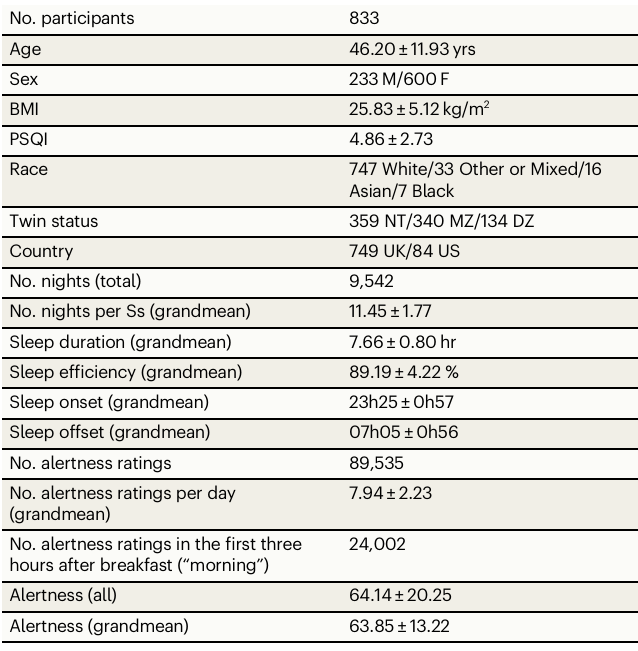
Valuesrepresentmean±standarddeviation,orcountsforsex,race,twinstatusandcountry.The grandmeanistheaverageoftheindividual ’ saverageacrossthe14daysofthestudy.Sourcedata areprovided as a Source Data fi le. BMI bodymassindex, PSQI Pittsburgh Sleep Quality Index, NT non-twin, MZ monozygotic, DZ dizygotic, Ss